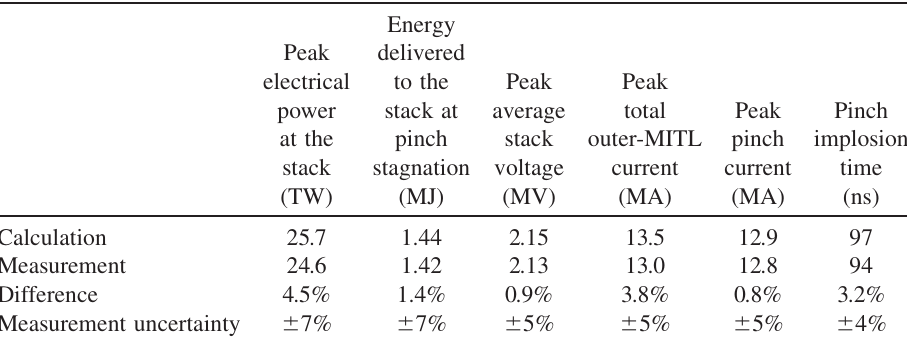
TABLE IX. Comparison of TL -model calculations with measurements taken on the Z accel- erator. The measurements are average values of data acquired on two nominally identical Z shots. The load was a z pinch with a 1-cm length, 1-cm initial radius, and 2.74-mg total mass. The Marx-charge voltage on these shots was 60